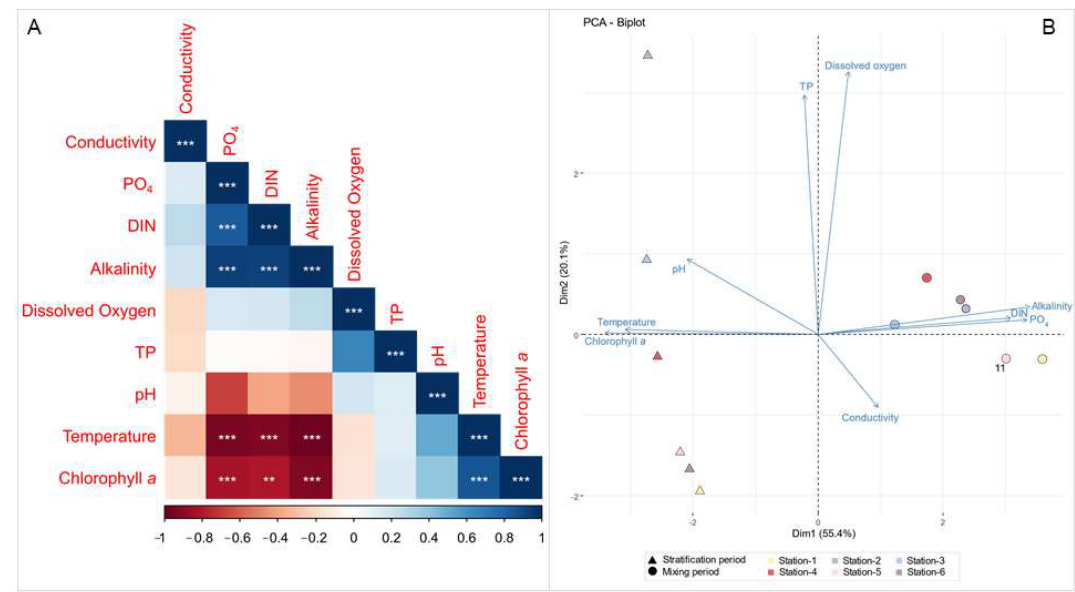
Figure 2. ( A ) The correlations for the environmental parameters. Blue and red colors stand for the positive and negative correlations, respectively, in which the intensity is proportional to the correlation coefficient (asterisks indicate significant correlations: ** p < 0.05. *** p < 0.001). ( B ) Variable-factor map (colors indicate the sampling sites, shapes indicate the sampling periods).